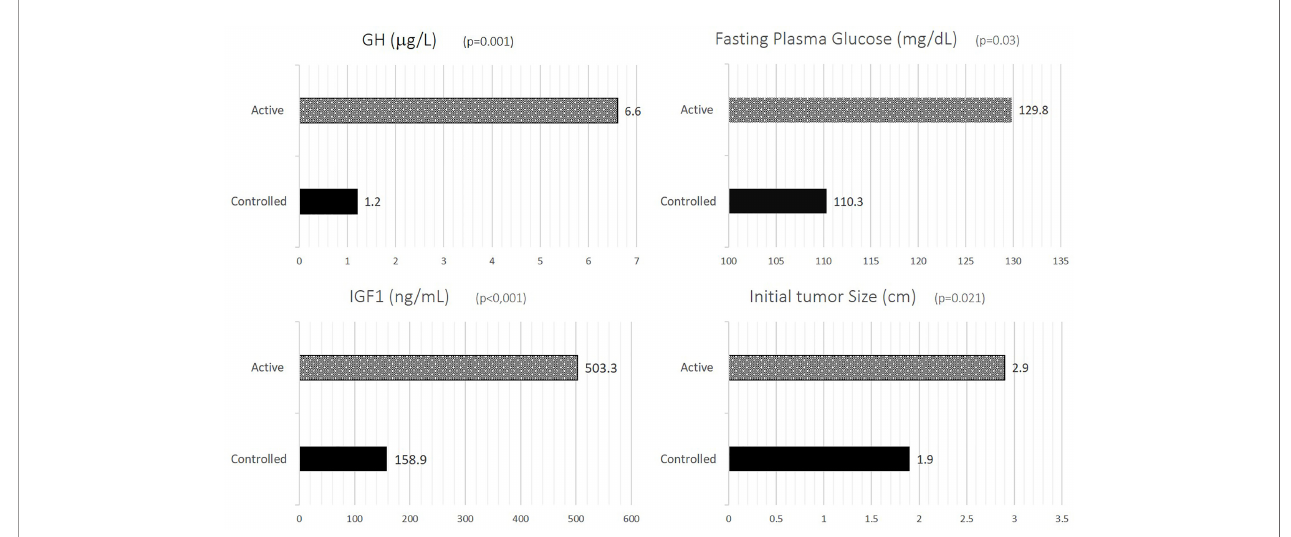
FIGURE 1 | GH, IGF-1, FPG and initial tumor size according to disease activity. GH, growth hormone; IGF-1, insulin-like growth factor-1; FPG, fasting plasma glucose.